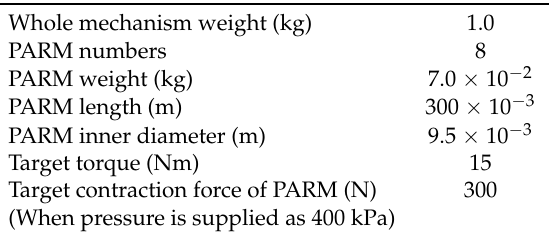
Figure 2. Attachment unit of the novel gait assistive suit actuated by PARMs. Compared with the previous suit [18] which has a rigid link system, the novel suit consists of only lightweight and soft parts as PARMs, waist supporter, knee supporters, nylon belts and shoes. The 8 PARMs are placed on the surfaces of the legs. The PARMs on the right leg are named as the right thigh front (RTF), right thigh back (RTB), right calf front (RCF), and right calf back (RCB). The PARMs on the left leg are named in the same manner (LTF, LTB, LCF, LCB). Table 1. Parameters of the attachment